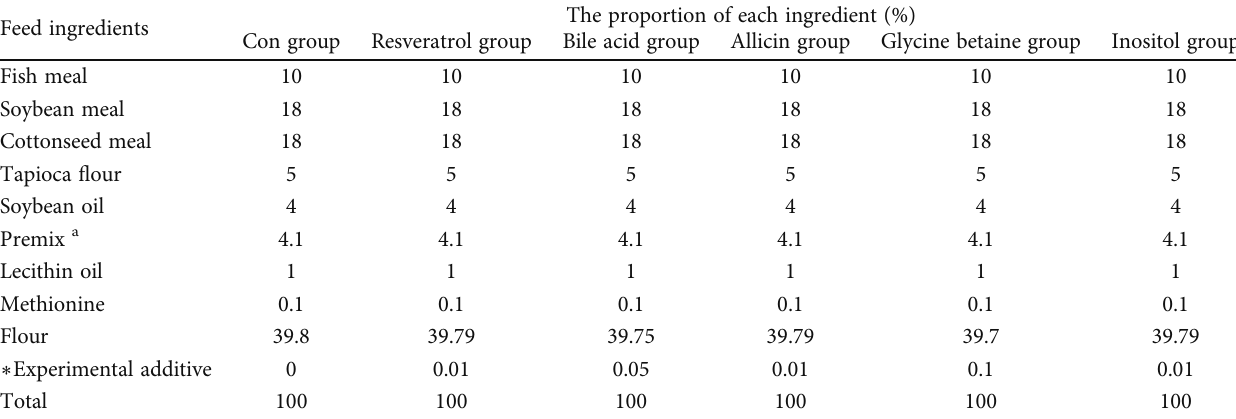
Table 1: Formulation and composition of experimental diets